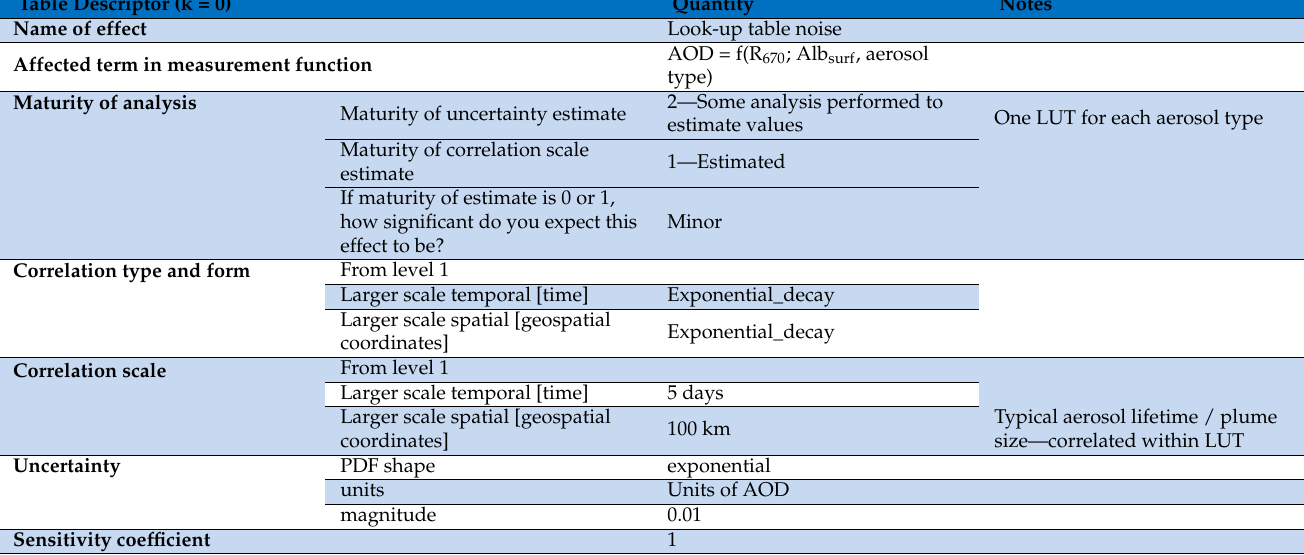
Table 5. Effects table for LUT interpolation.